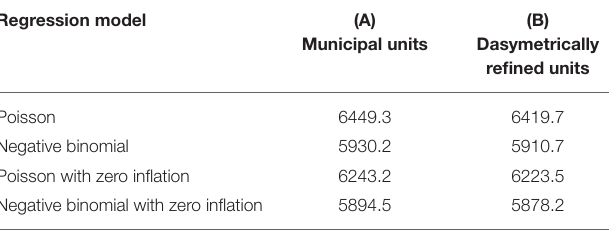
FIGURE 5 | Observed canine cancer incidence rates across Swiss municipalities in 2008. The data is classified according to the quantile classification method and mapped using dasymetrically refined units. TABLE 1 | AIC measures for the different regression models based on the two enumeration types — (A) municipal units and (B) dasymetrically refined units.